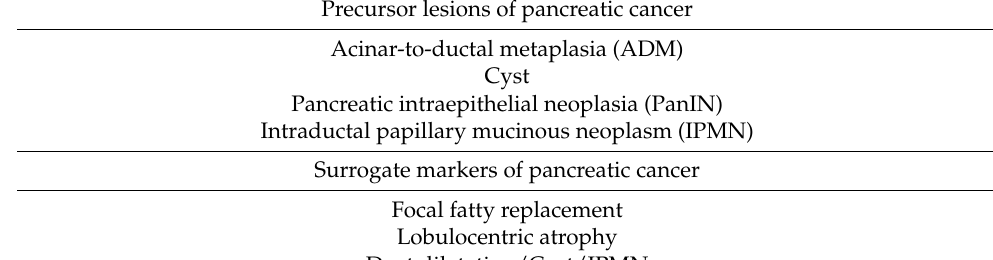
Table 1. Cancer-related pathological changes in the human pancreas.